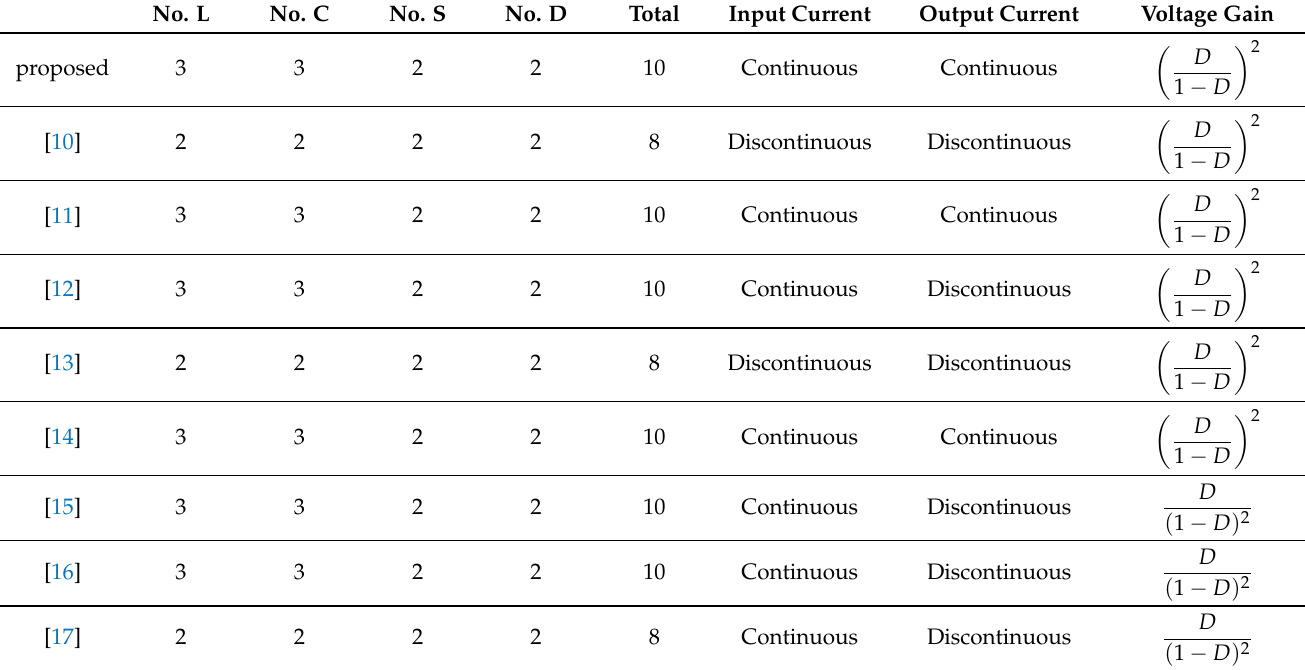
Table 5. Comparison of component numbers and voltage